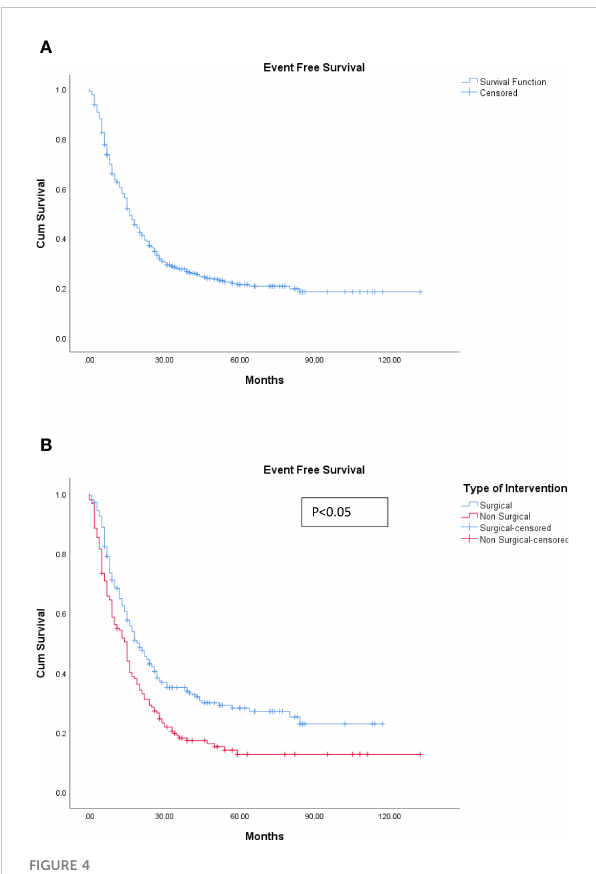
FIGURE 4 (A) Event-free survival. (B) Event-free survival: surgical and non- surgical LDT. LDT, liver-directed